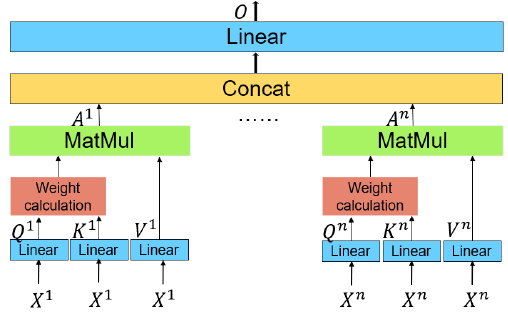
Figure 1. Schematic diagram of the multi-head attention.